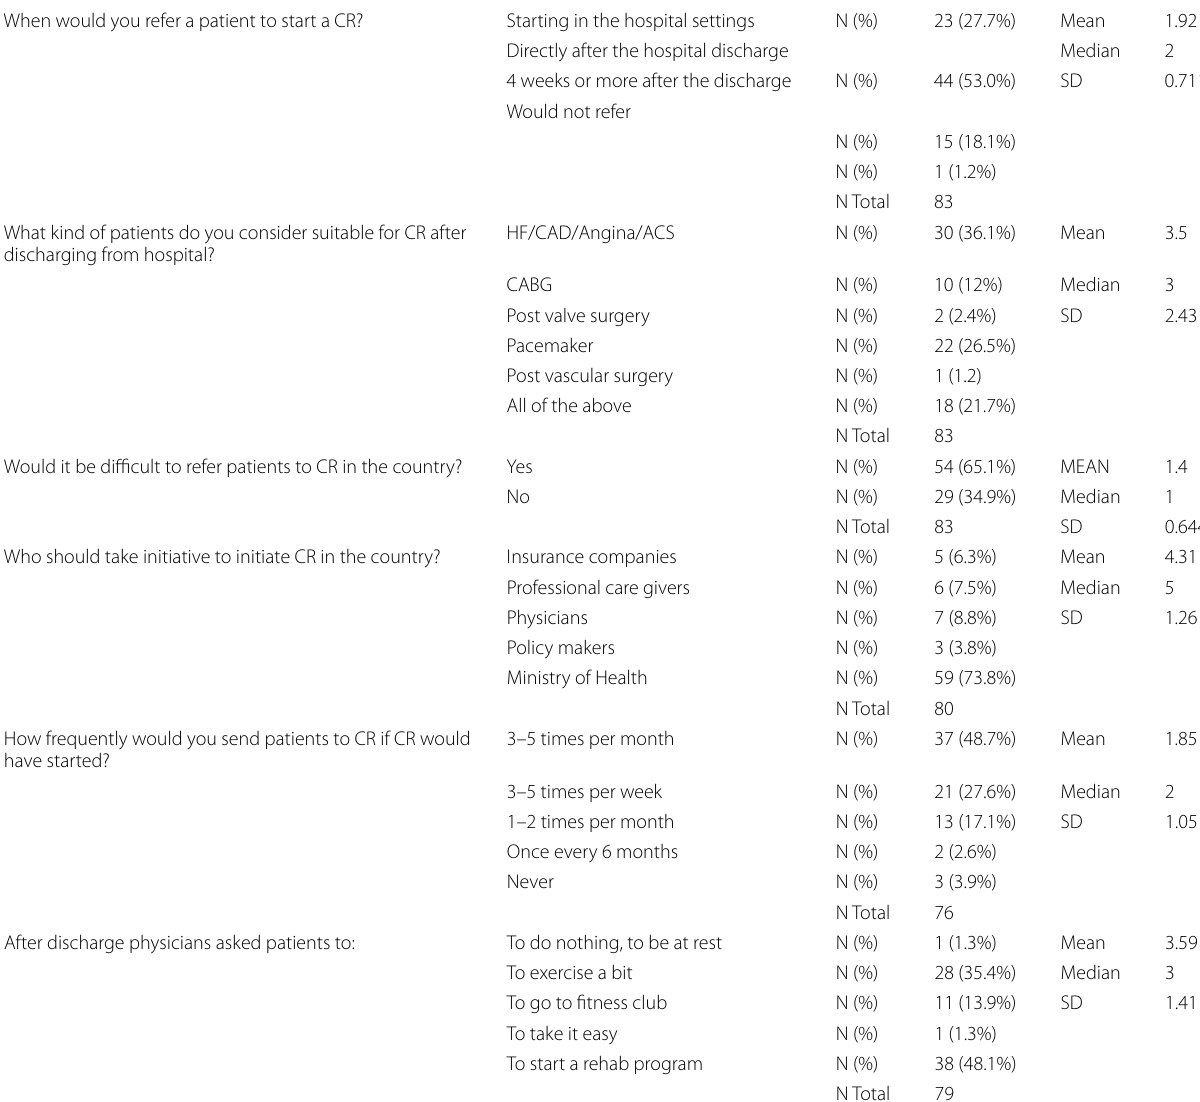
Table 4 Practice of cardiac rehabilitation (CR) by the respondents When would you refer a patient to start a